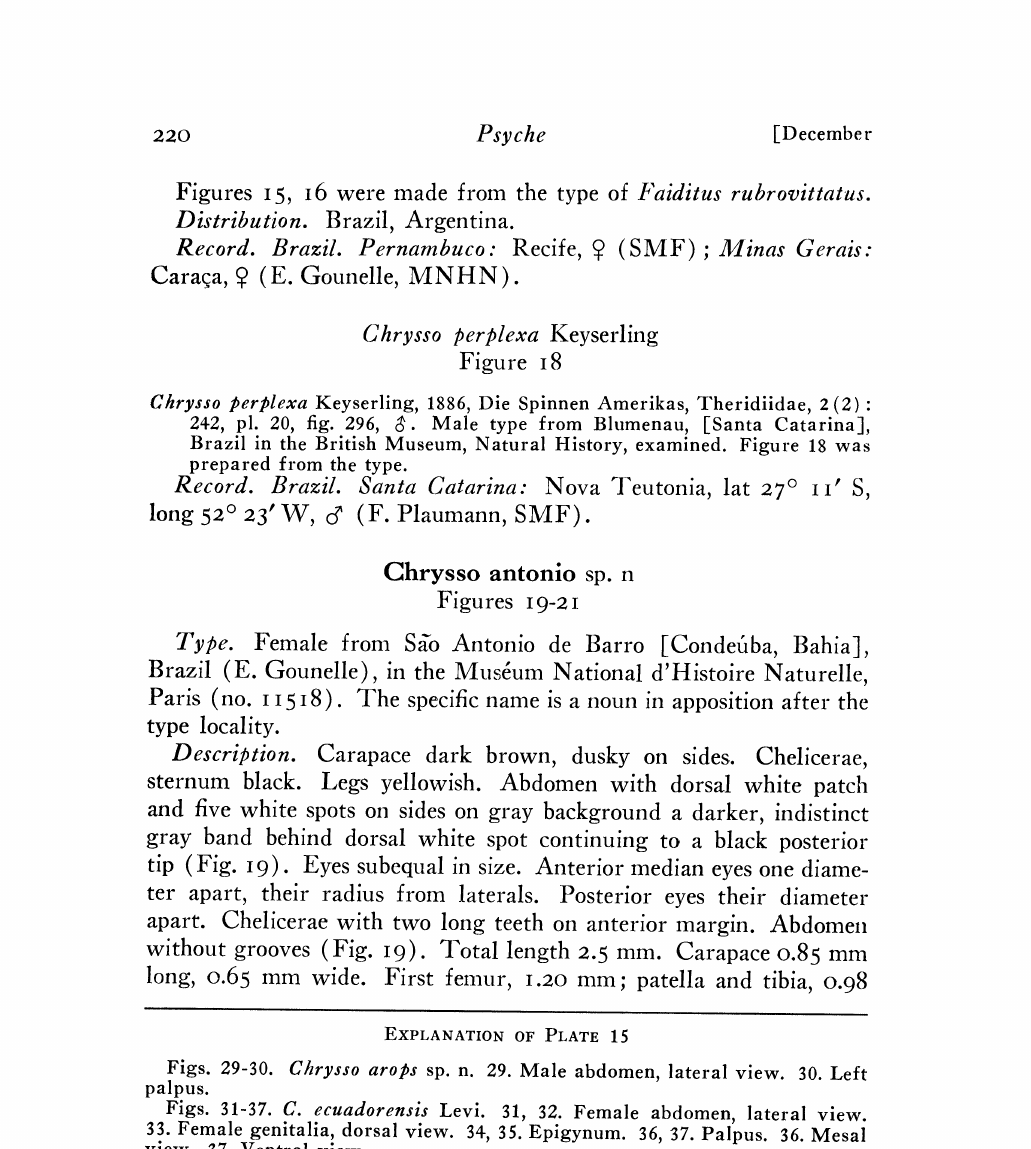
Figs. 29-30. Chrysso arops sp. n. 29. Male abdomen, lateral view. 30. Left palpus. Figs. 31-37. C. ecuadorensis Levi. 31, 32. Female abdomen, lateral view. 33. Female genitalia, dorsal view. 34, 35. Epigynum. 36, 37. Palpus. 36. Mesal view. 37. Ventral view. Figs. 38-42. C. ittatula (Roewer). 38. Female abdomen, lateral view. 39. Female genitalia, dorsal view. 40. Epigynum. 41, 42. Palpus. 41. Mesal view. 42. Ventral view. Figs. 43-47. C. cambridtTei (Petrunkevitch). 43. Female, lateral view. 44. Female genitalia, dorsal view. 45. Epigynum. 46. Palpus expanded, mesal view (cymbium removed; C, conductor; E, embolus; M, median apophysis; R, radix). 47. Palpus. Figs. 48-51. C. barromachadoi Caporiacco. 48. Abdomen of juvenile, lateral view. 49. Female genitalia, dorsal view. 50. Epigynum. 51.